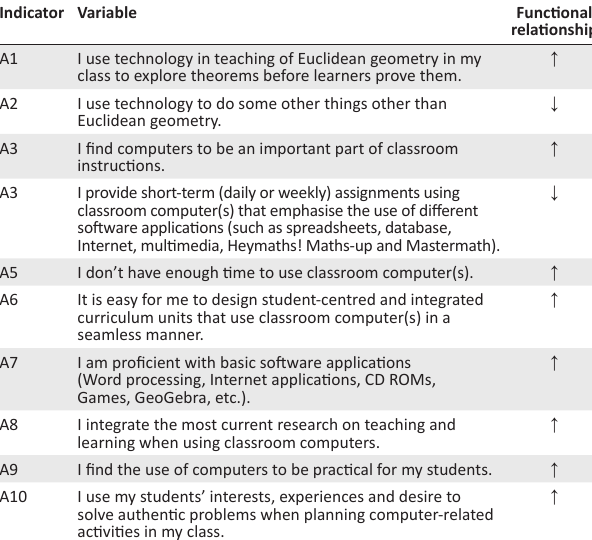
TABLE 3: Functional relationship of indicators with use of technology. Indicator Variable